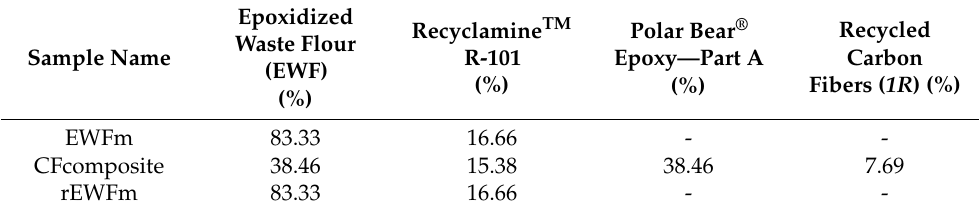
Table 1. Composition of EWF-matrix and composite-produced samples (as